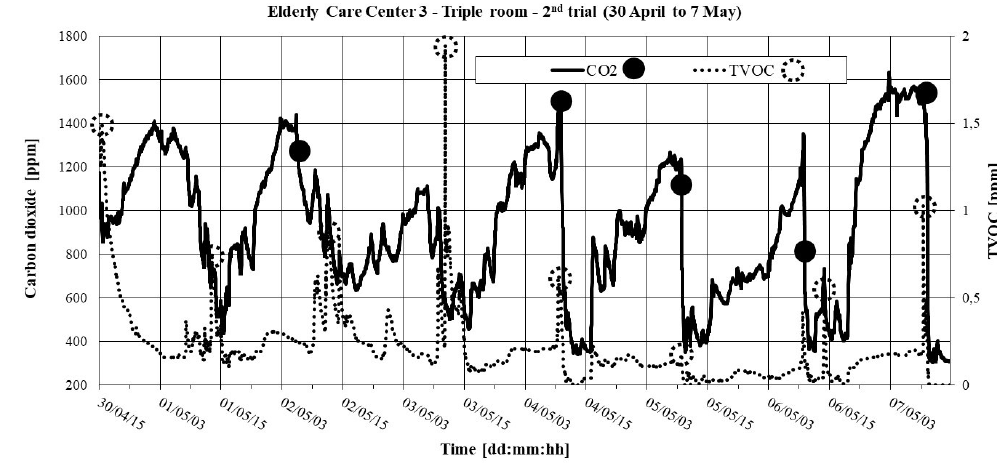
Figure 5. CO 2 and TVOC in the triple room in ECC 3: 2 nd trial (30 April to 7 May).